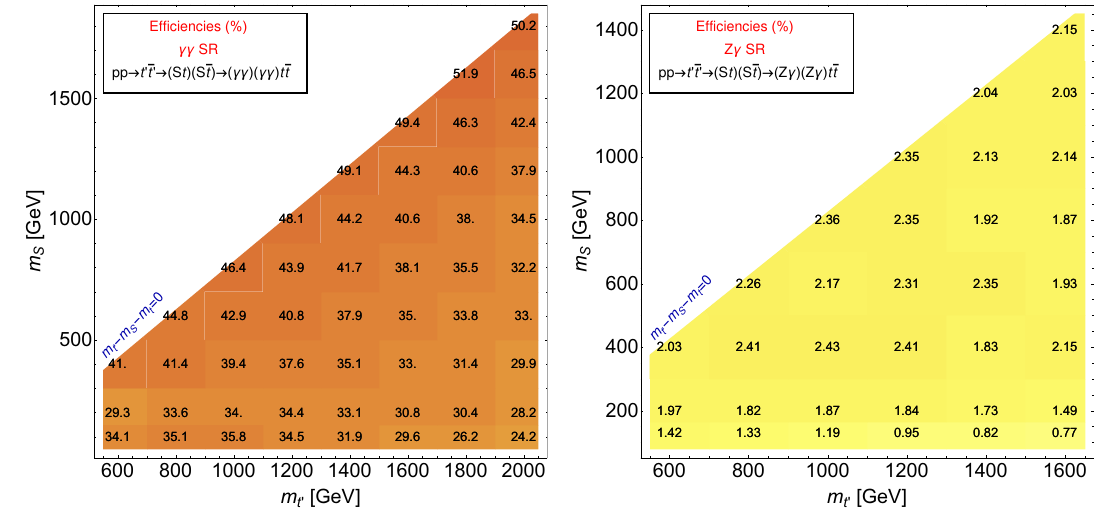
Figure 9 . Left: e(cid:14)ciencies for the (cid:13) (cid:13) SR for the signal decay channel S ( ! (cid:13) (cid:13) ) S ( ! (cid:13) (cid:13) ). Right: e(cid:14)ciencies for the Z (cid:13) SR for the signal decay channel S ( ! Z (cid:13) ) S ( ! Z (cid:13) ).